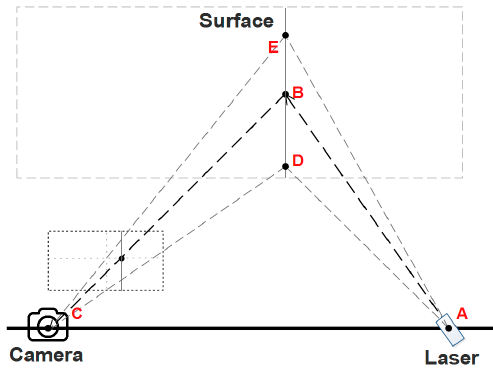
Figure 5. Principle of structured light scanner.